Question: Which visualization type does this figure use?
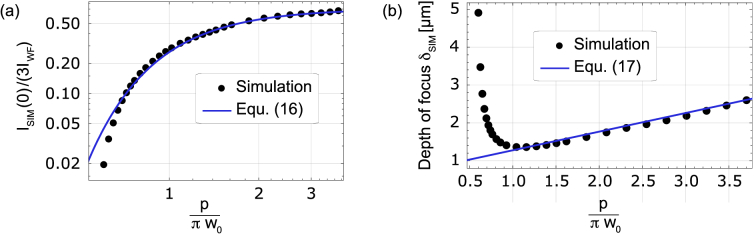
Answer: line